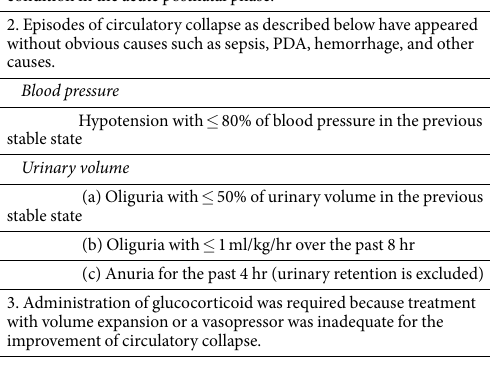
Table 1. Diagnostic criteria of